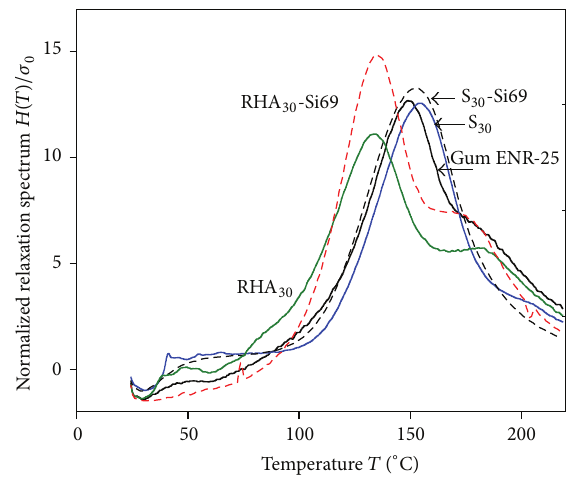
Figure 13: Normalized relaxation spectrums as a function of temperature of gum and filled ENR-25 vulcanizates with 30 phr of RHA and silica with and without silane coupling agent